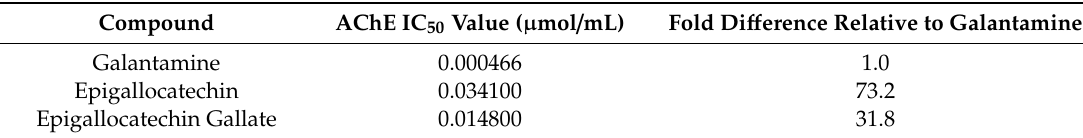
Table 4. Active compound IC50 value comparisons.